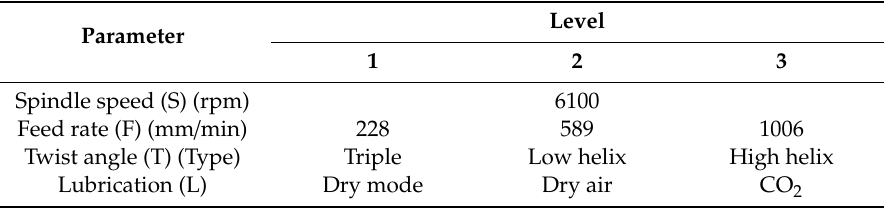
Table 3. Parameter of drilling process.